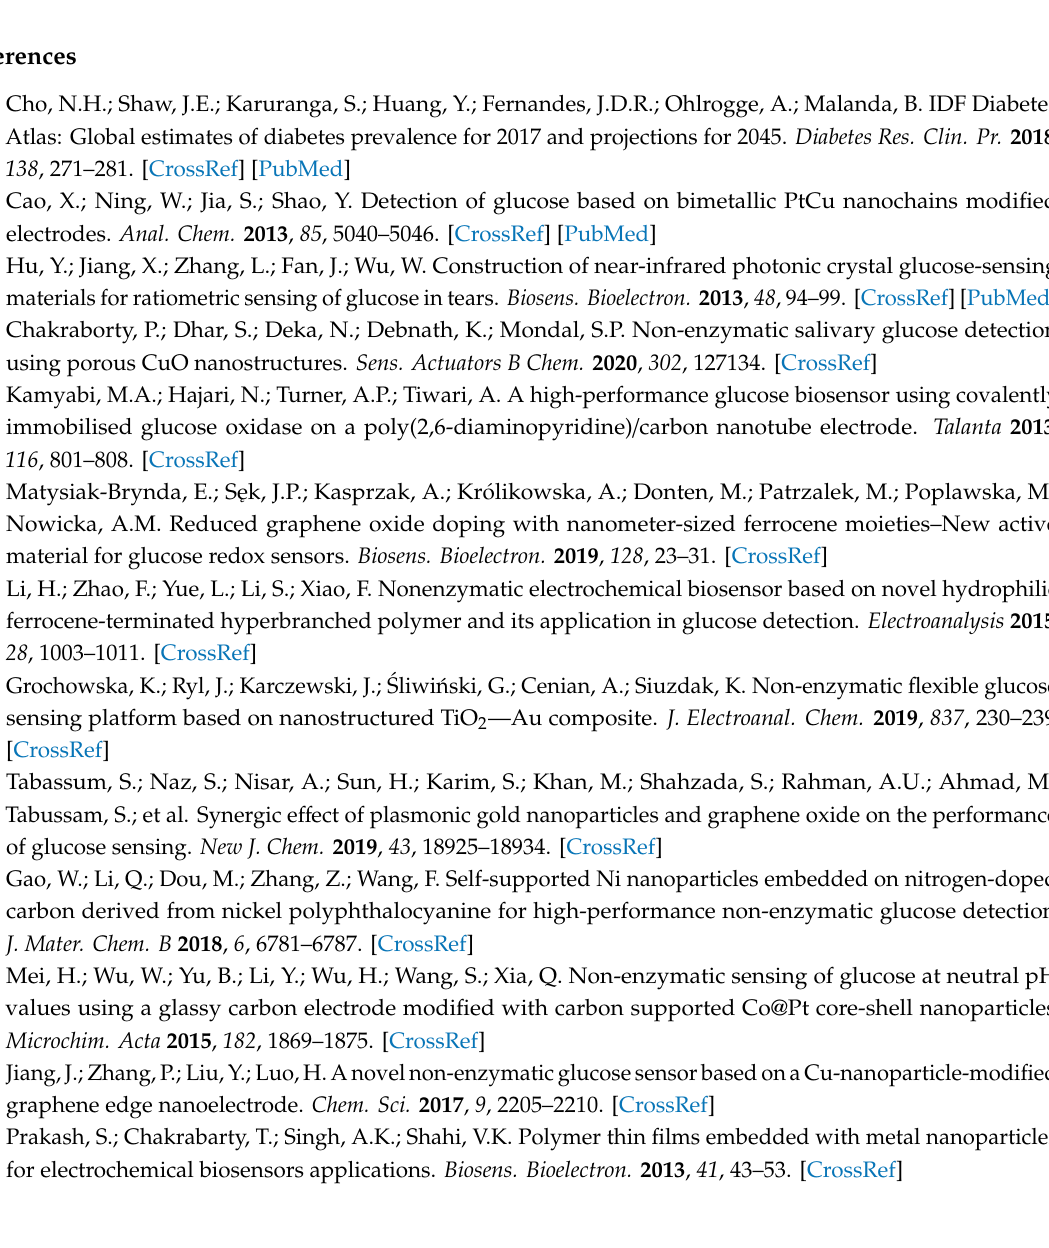
Figure S1: SEM of (a) pristine CNT and (b) Fc-CHIT / CNT, inset images are the EDS and element content, Figure S2: CVs of Fc-CHIT / CNT, CHIT / CNT@Cu and Fc-CHIT / CNT@Cu electrodes in 0.1 M NaOH electrolyte (a) without glucose and (b) with 1 mM glucose, Figure S3: The relationship between glucose concentration and current value of CHIT / CNT@Cu, Fc-CHIT / CNT and Fc-CHIT / CNT@Cu modified GCE electrodes, Figure S4. (a) Chronoamperograms obtained with di ff erent NaOH concentrations and 0.1 M KOH; (b) Current values of NaOH concentrations or 0.1 M KOH with 4 mM glucose, Figure S5: The current response of the Fc-CHIT / CNT@Cu electrode to the addition of AA, DA, UA, glucose with di ff erent electrolyte pH and